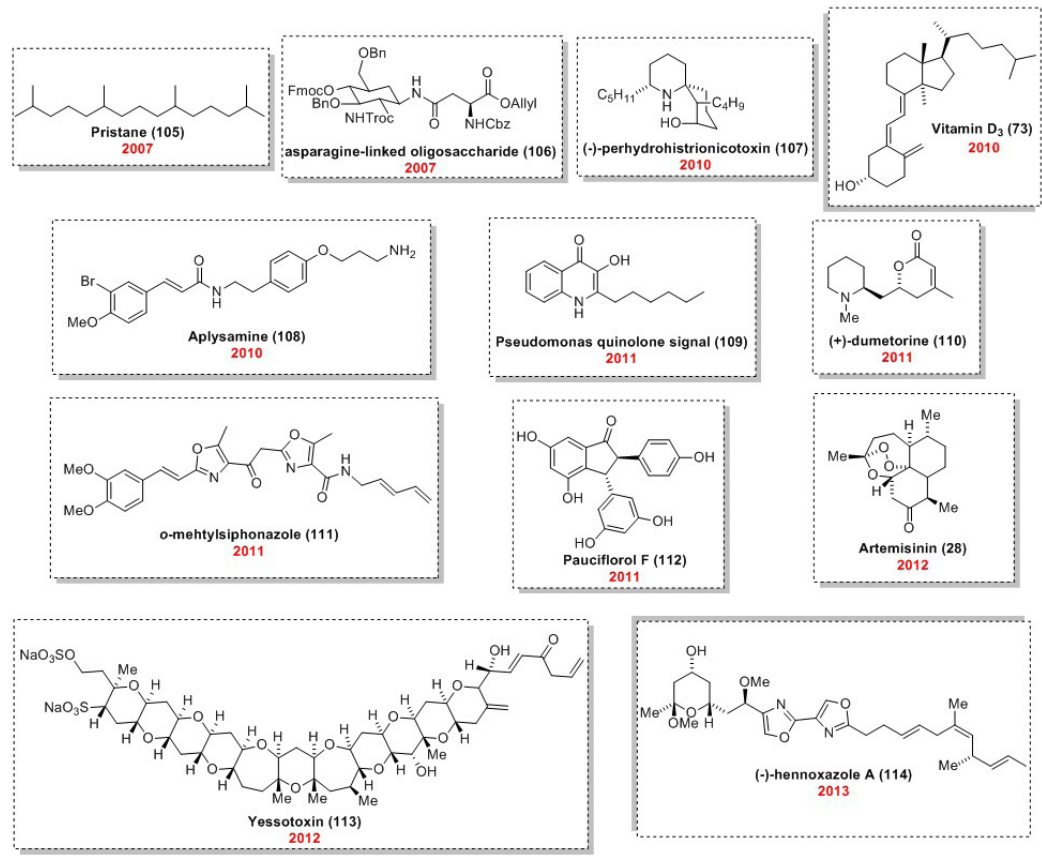
Figure 6 - NPs prepared using combined batch and continuous flow processes up to 2013.